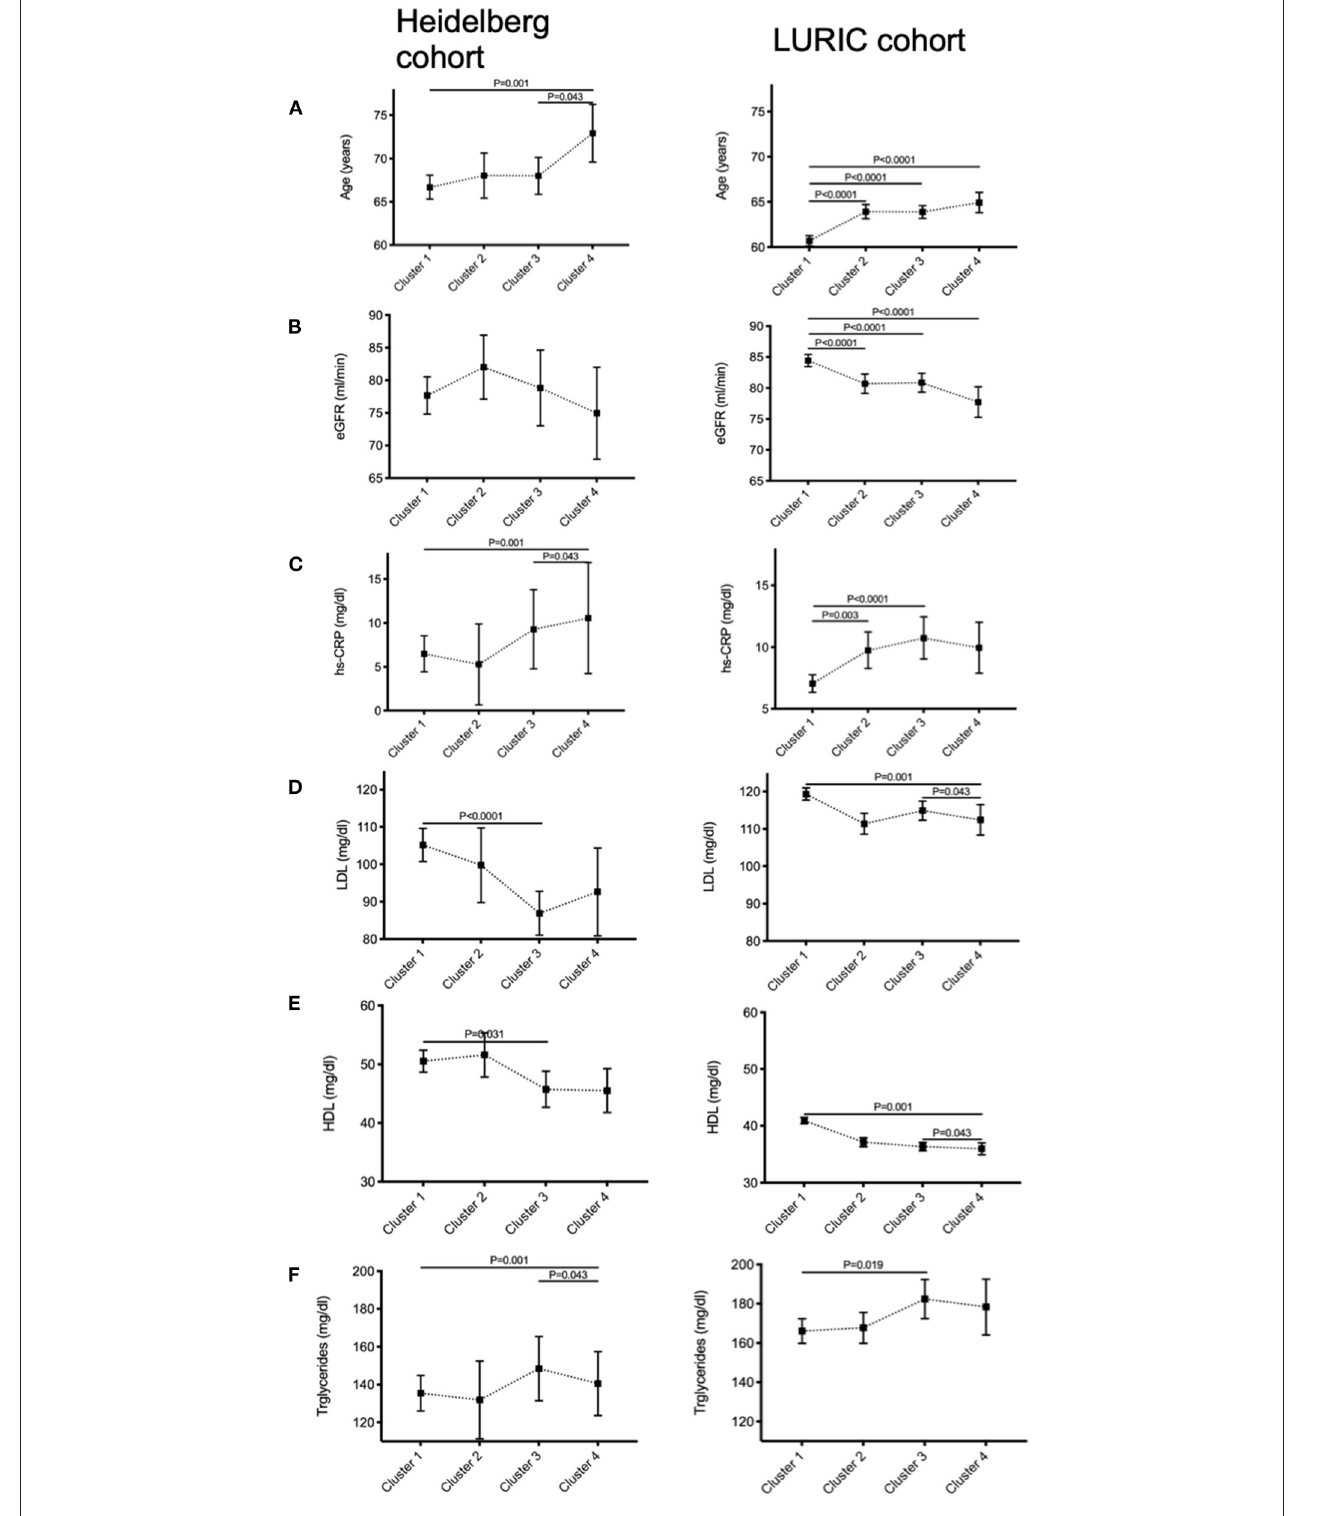
FIGURE 3 | Demographic characterization of each cluster reveals significant differences in cardiovascular risk profile. Comparison between the four phenotypic clusters of the Heidelberg “complete cohort” and the LURIC cohort with respect to (A) age, (B) renal function, (C) residual inflammation quantified by high-sensitive C-reactive protein levels (hs-CRP), (D) LDL-, (E) HDL-cholesterol, and (F) triglyceride levels using analysis of variance (ANOVA).